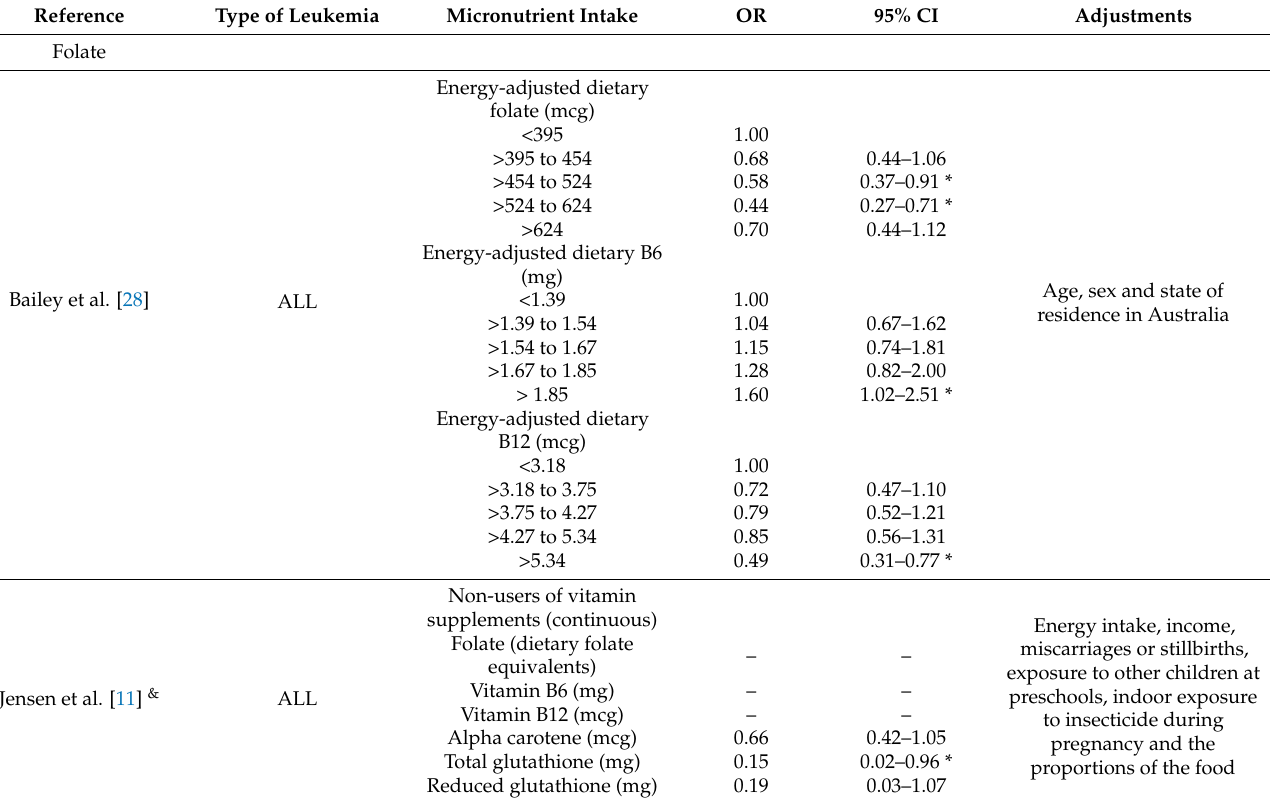
Table 9. Overview of the association between maternal micronutrient intake during pregnancy (or period specified) and risk of acute leukemia in